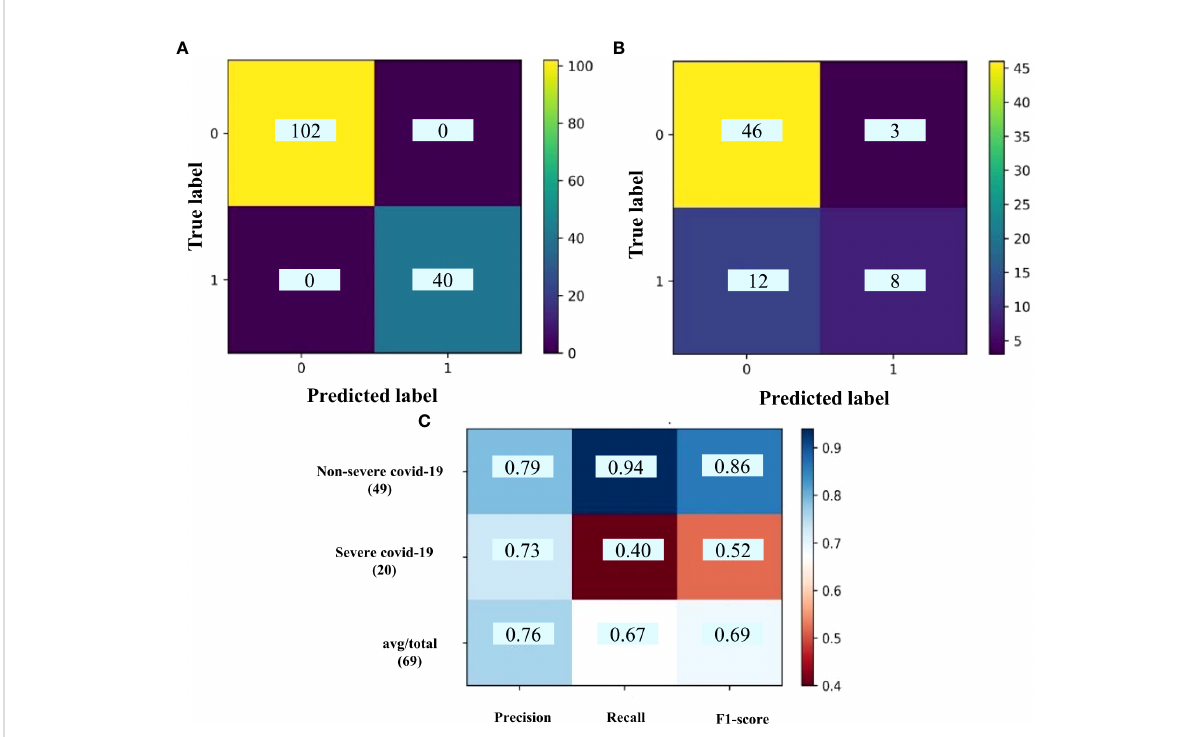
FIGURE 7 The confusion matrix of (A) train set and (B) test set; (C) classi fi cation report for DE_Smodules of brown. The confusion matrix shows the number of true and predicted label in non-severe COVID-19 (label 0) and severe COVID-19 (label 1) subjects. The classi fi cation report demonstrates the precision, recall, and F1-score for each